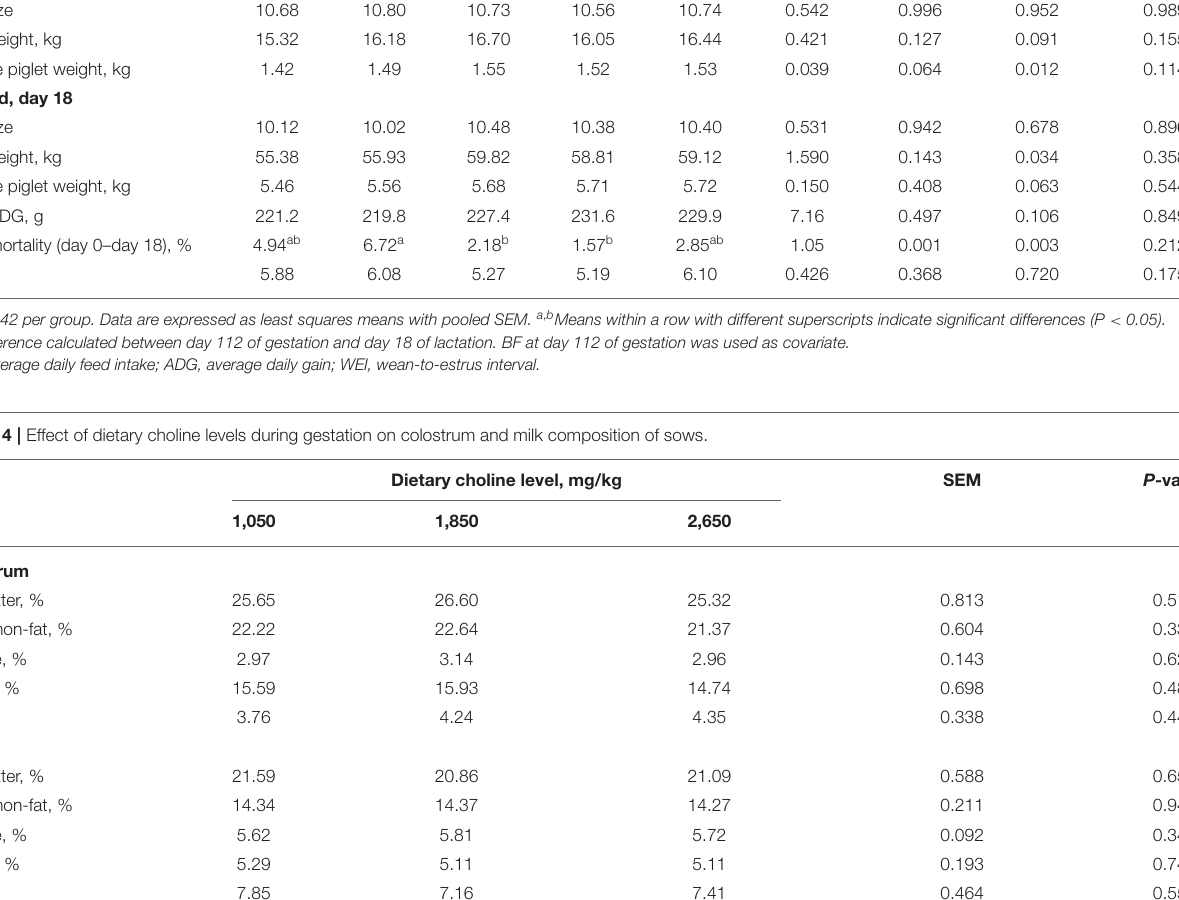
ANOVA Linear Quadratic